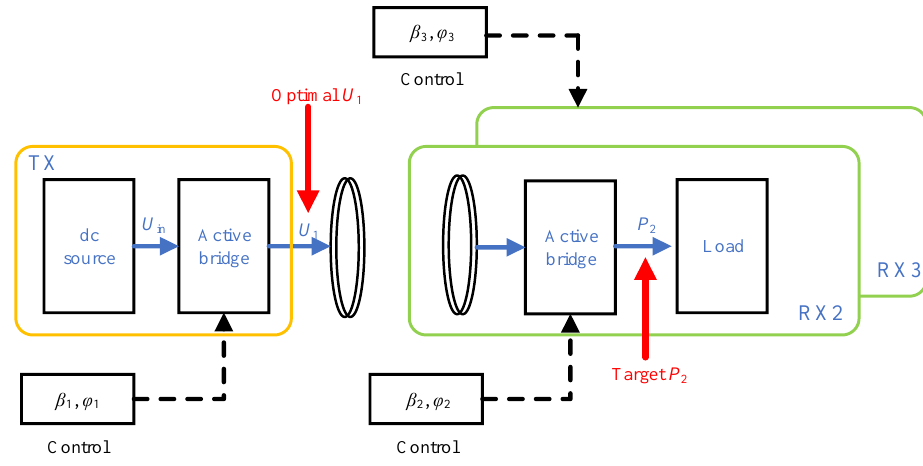
Figure 6. Two-receiver WPT system configuration.